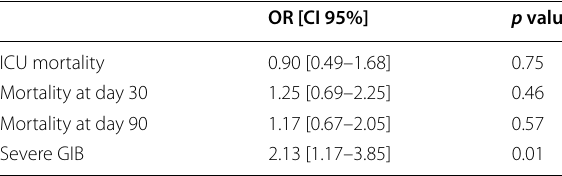
Table 4 Comparison case–control after